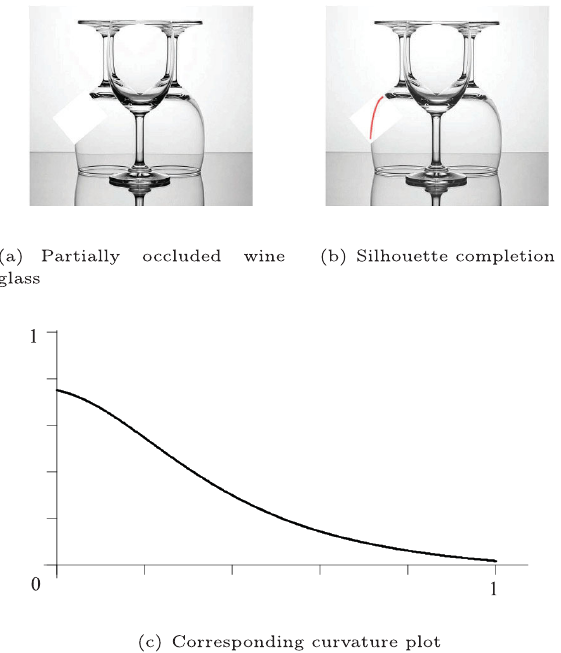
Fig. 13 Wine glass silhouette completion using Algorithm